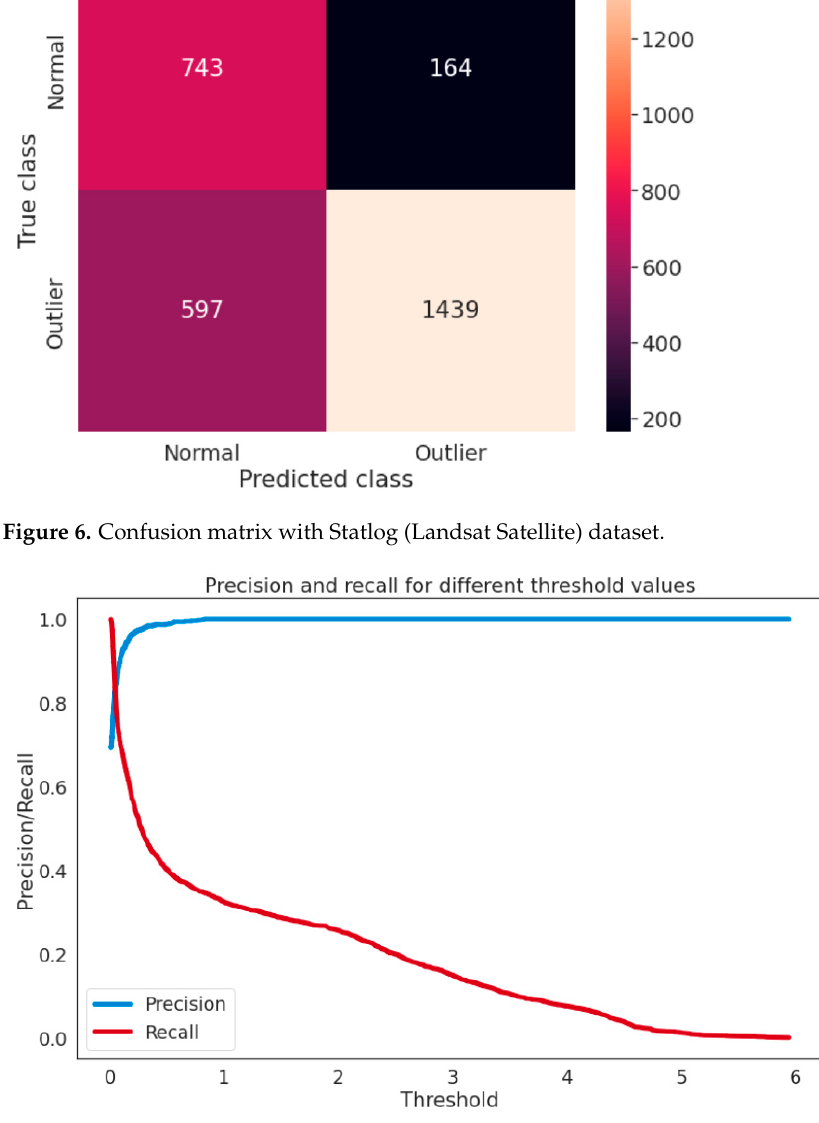
Figure 6. Confusion matrix with Statlog (Landsat Satellite) dataset.